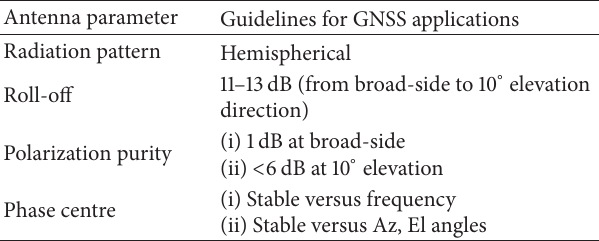
Table 2: GNSS antenna design guidelines.